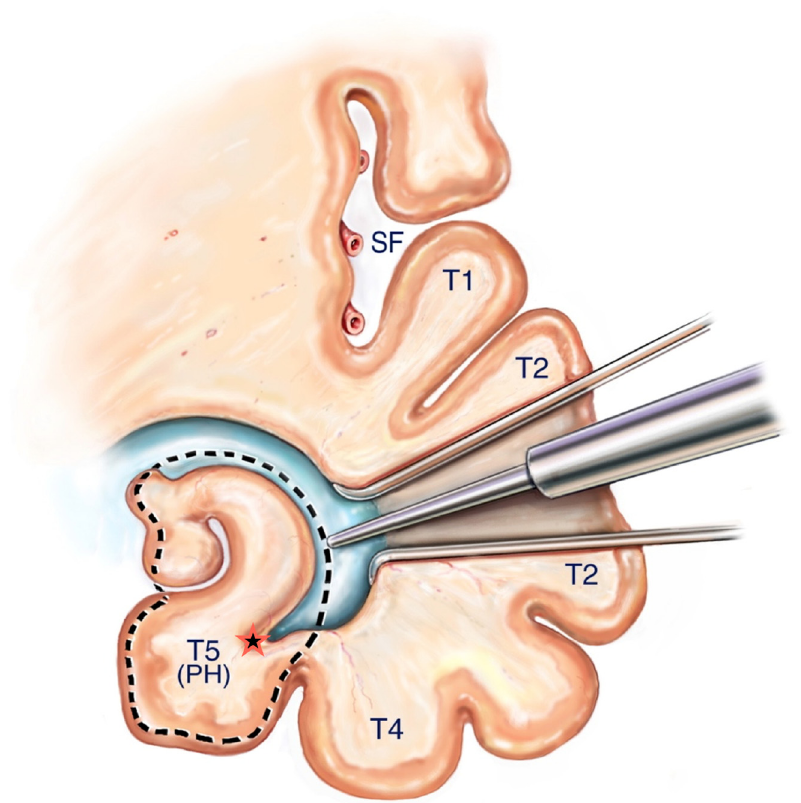
Figure 6. Reprinted from Journal of Clinical Neuroscience 17 (9), Boling W, Minimal access keyhole surgery for mesial temporal lobe epilepsy, 1180–1184, Copyright 2010, with permission from Elsevier, [59]. Coronal view of the temporal lobe and nearby structures. A retractor is placed along the white matter corridor after opening the ventricle to fully expose its contents. The first step in the SAH is to enter the lateral ventricular sulcus (star) that lies between the bulges into the ventricle of the hippocampus and collateral eminence in order to empty the parahippocampus in a subpial fashion. Dotted line illustrates mesial temporal structures to be removed in this view, namely the hippocampal complex and parahippocampus. SF = Sylvian Fissure, T1= superior temporal gyrus, T2 = middle temporal gyrus, T4 = Fusiform gyrus, T5(PH) = parahippocampal gyrus.